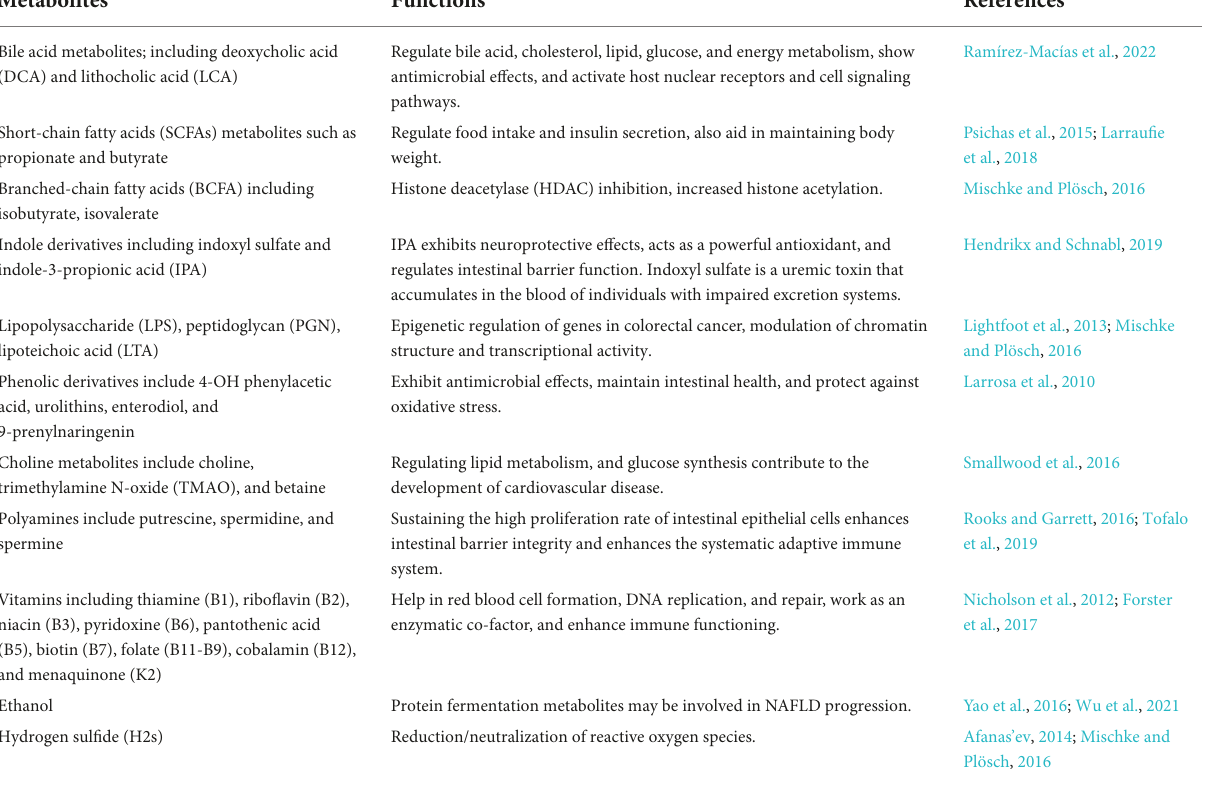
TABLE 1 Metabolites produced by gut microbiota and their